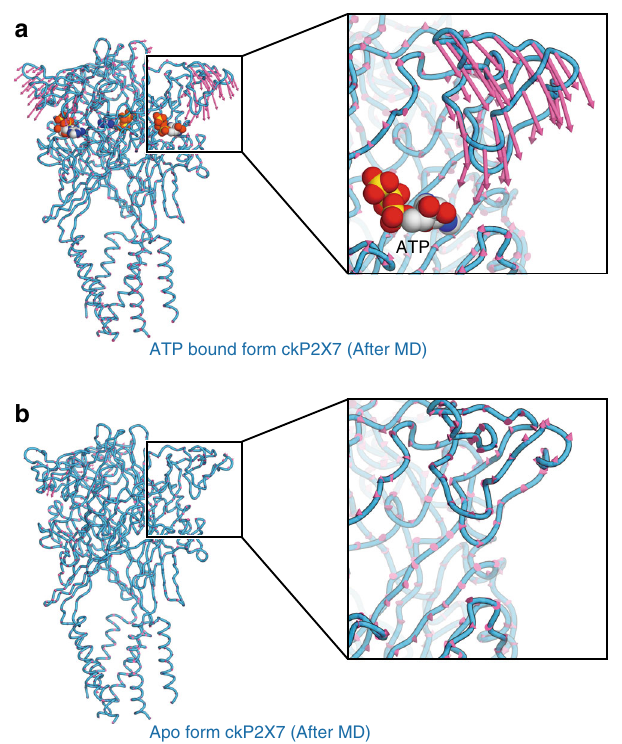
Fig. 5 Effects of the trinitrophenyl group of TNP-ATP upon binding to P2X receptors. a , b Representative P2X7 structures during the 200 ns MD simulations in the presence of ATP ( a ) and in the absence of ligand ( b ) at the ATP binding pockets. The pink arrows are vector representations of the motions of the extracellular domains in the principal component analysis (PCA) of the ckP2X7 cryst